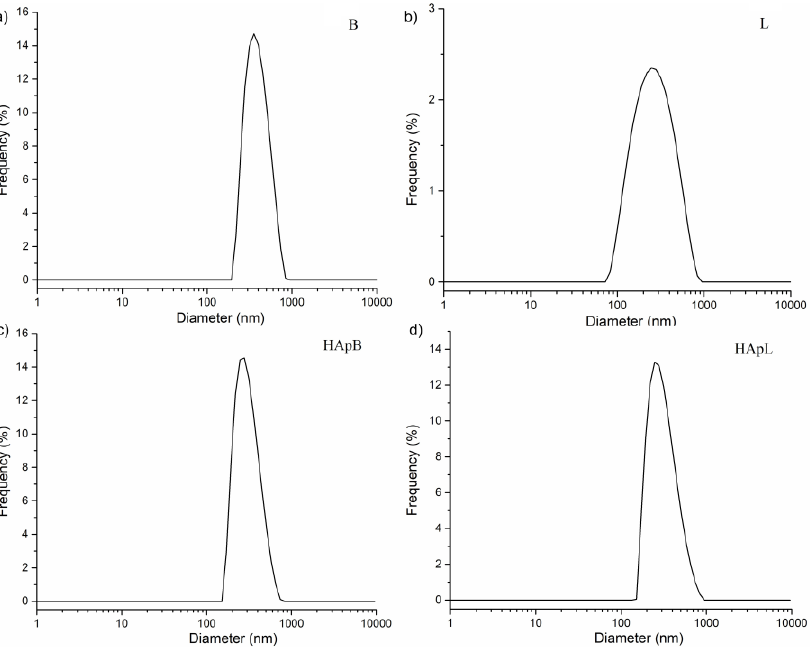
Figure 4. Particle size distributions of basil B ( a ); L ( b ); HApB ( c ) and HApL ( d ) obtained by fitting the experimental autocorrelation function. Table 3. Parameters comparison of mean particle size resulting from SEM and DLS